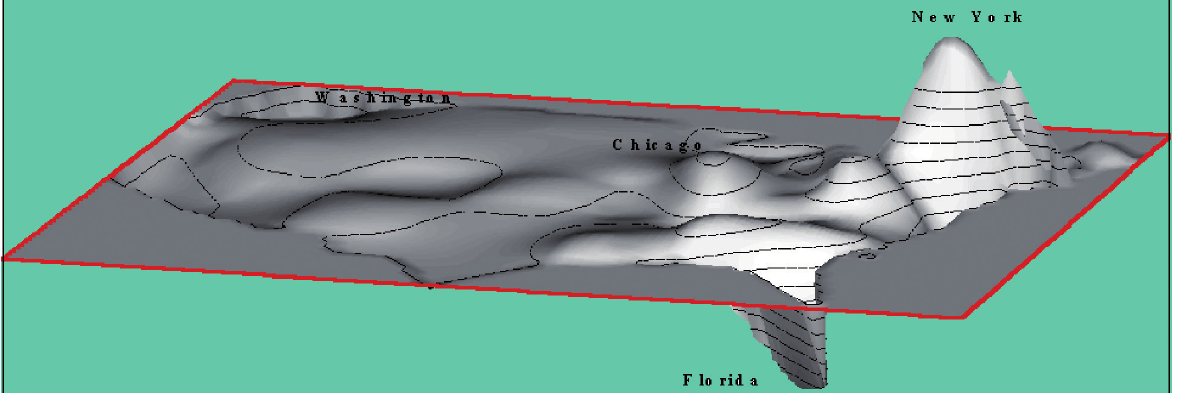
Fig. 5. Pressure to move, from the difference between in-migration and